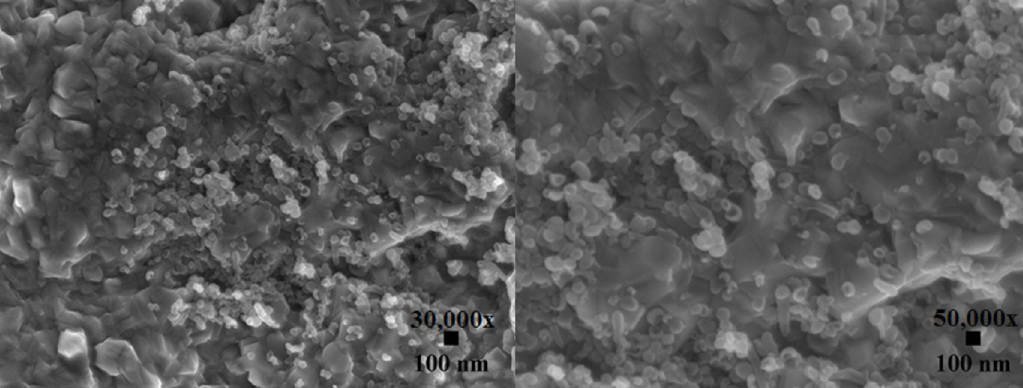
Figure 6. Nanopores and nanocrystals over the surface of anodized titanium with HCl at 15 V with a concentration of 0.15M in 60 min with a thermal treatment of 750 °C for 2